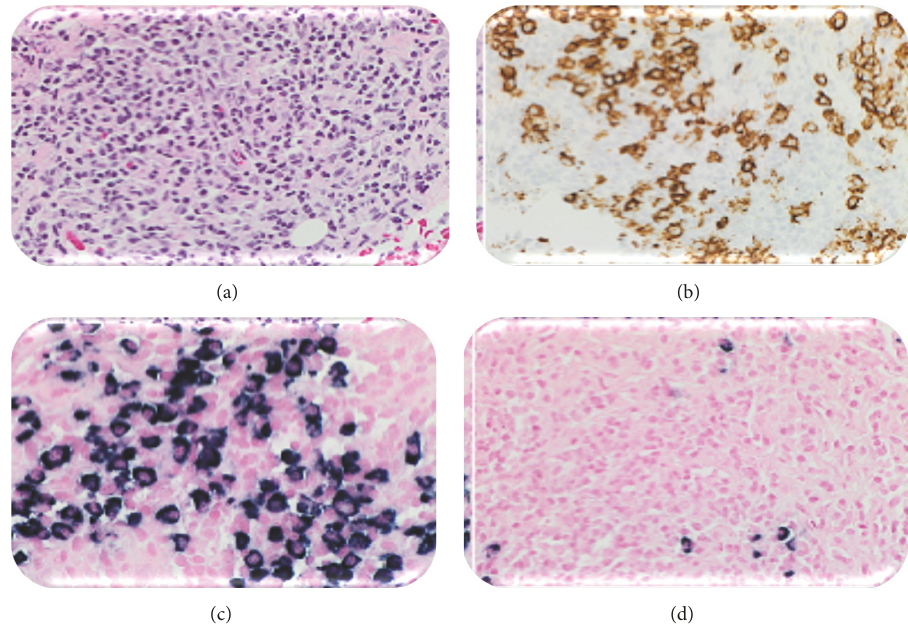
Figure 2: Left axillary lymph node biopsy. (a) Haematoxylin and eosin stain at × 40. (b) CD138 stain at × 40, strongly positive. (c) Kappa stain at × 40, strongly positive. (d) Lambda stain at × 40, negative demonstrating kappa light chain